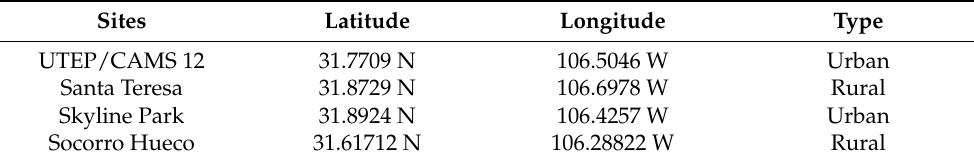
Table 2. Ground station locations in the Paso Del Norte region.